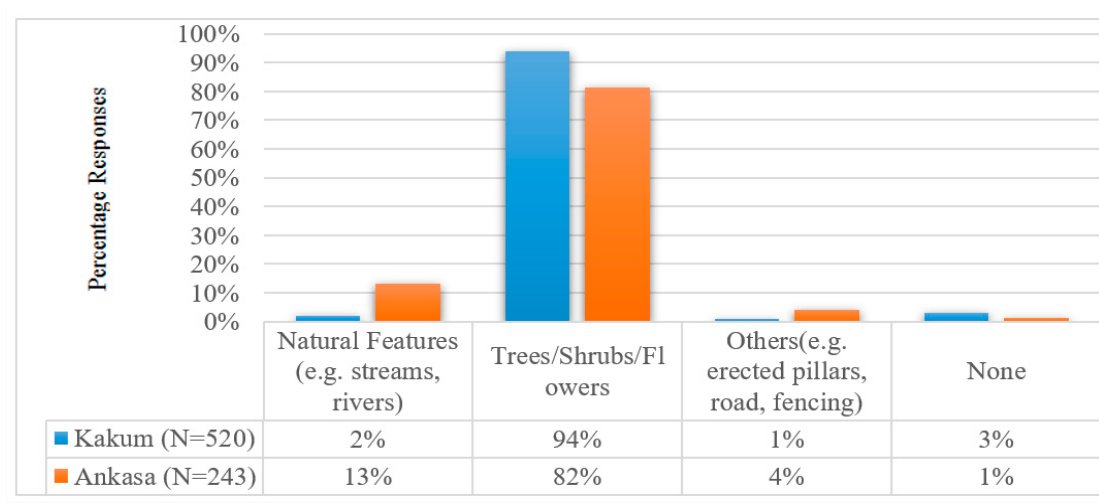
Figure 3. Type of farmland boundary indicators.